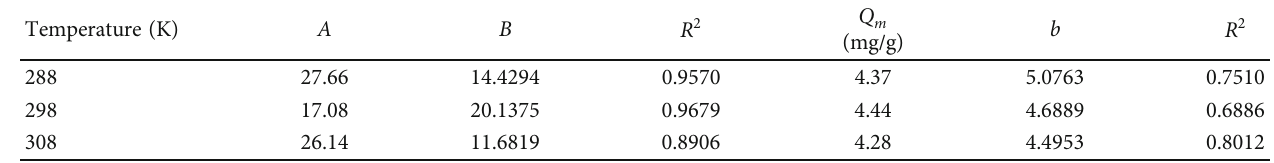
Table 7: Constants of Temkin and D-R isotherm models for Cr (VI) removal of CSBT. Temperature (K)